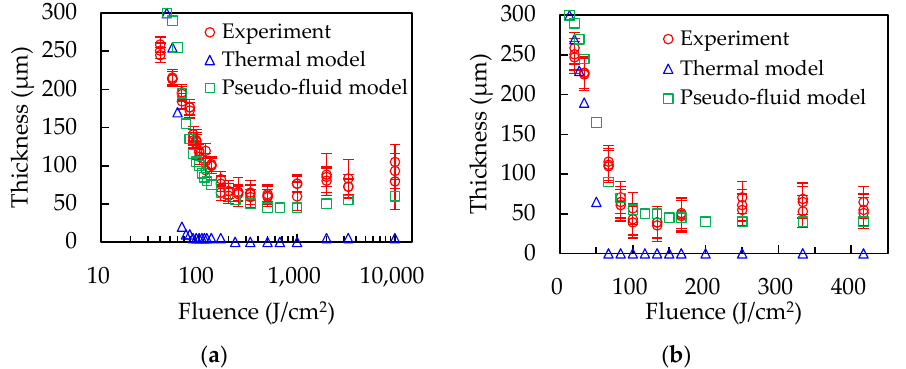
Figure 8. Comparison of the thermal and pseudo-fluid model with the experimental results. ( a ) PP, ( b ) PET.